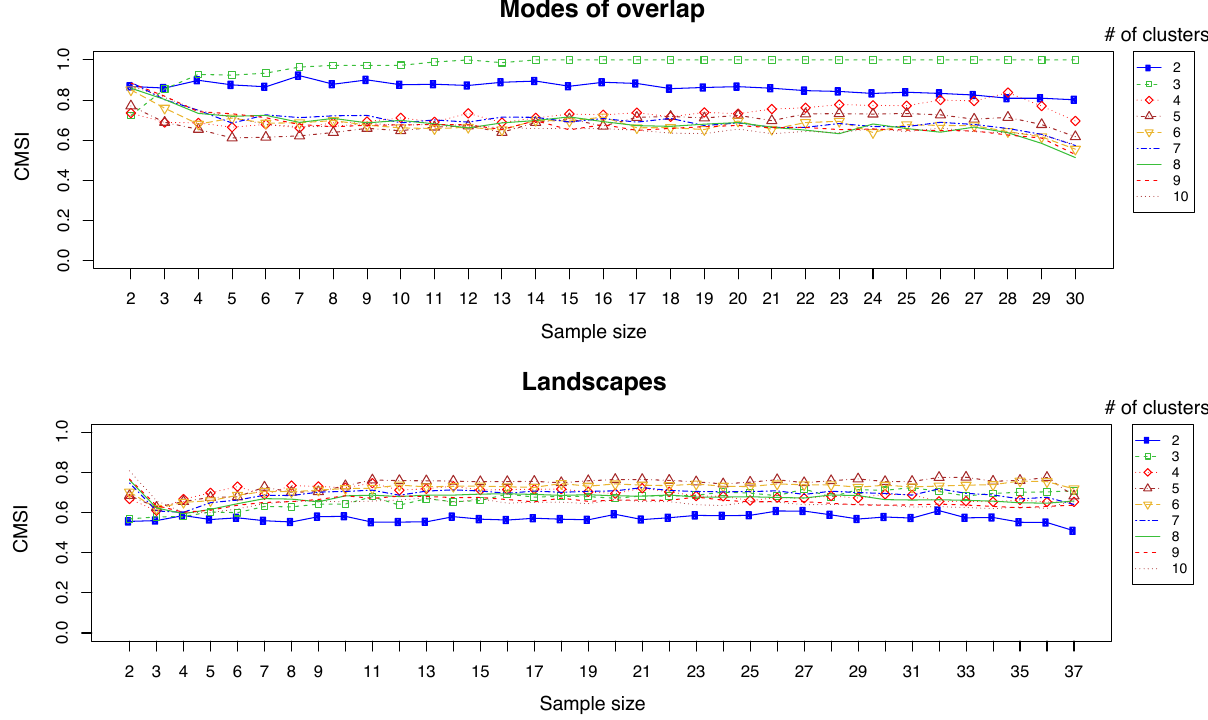
Figure 4: Results of cluster validation using CMSI for two experiments. Top: experiment on overlap relations (see Figure 5 (left)); bottom: experiment on landscape conceptualizations (see Figure 5 (right)).